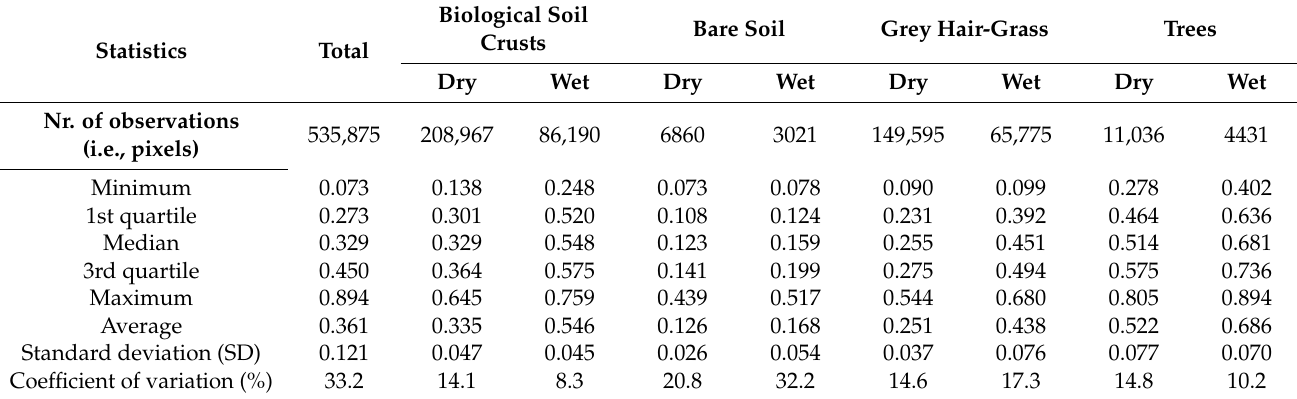
Table 3. Descriptive statistics of the Sentinel-2-based NDVI observations for the two example periods from day-of-year (DOY) 273 to 321 in October/November 2018 and from DOY 68 to 120 in March/April 2020 for each land cover class separated for dry and wet conditions. Hereby, the NDVI values for DOY 84 in 2020 were omitted, as they represent intermediate